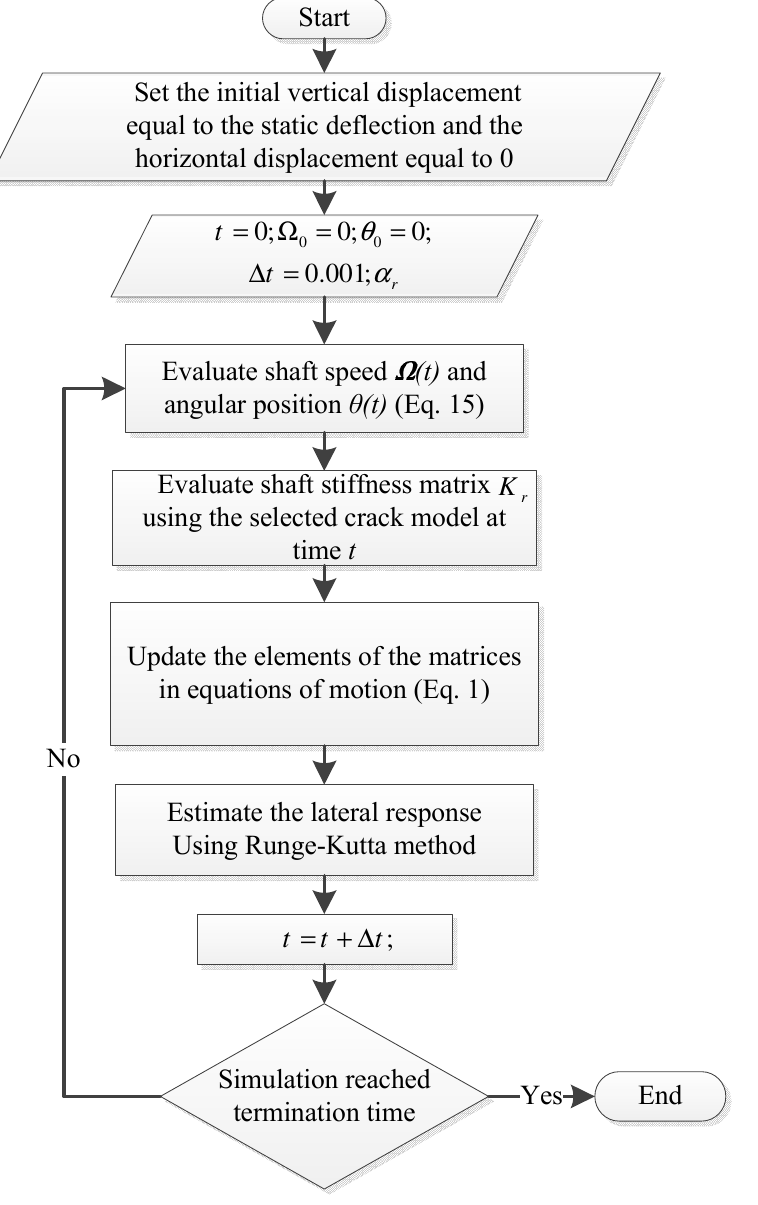
Figure 5. The transient lateral response solution